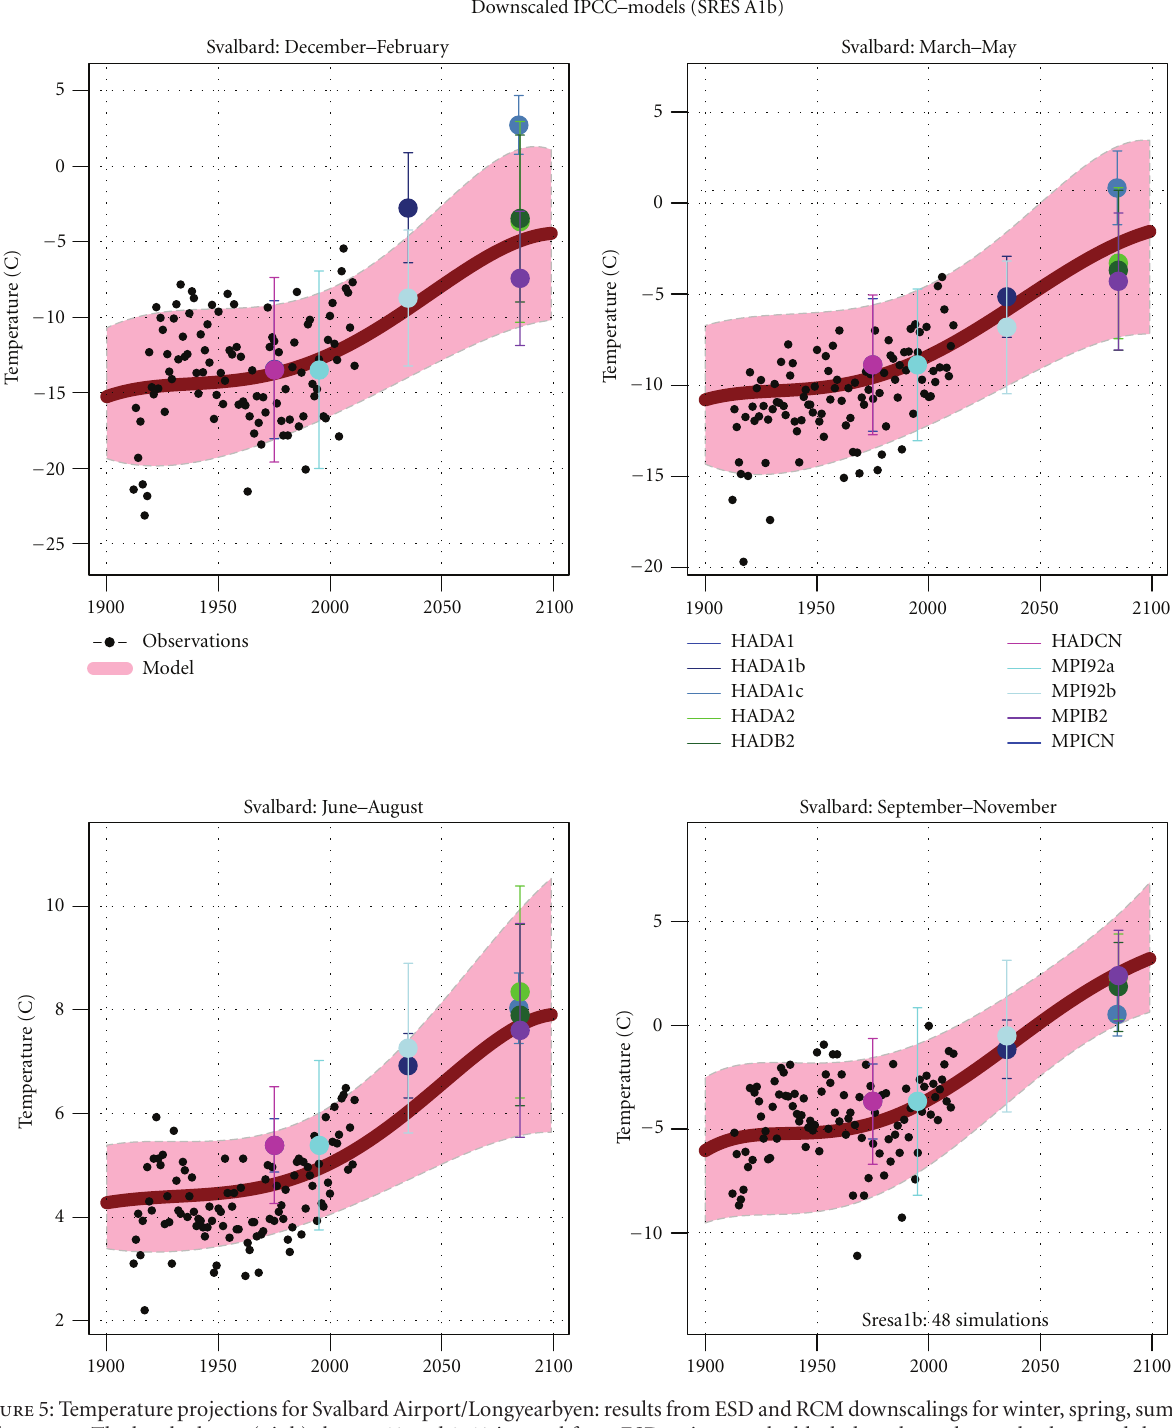
Figure 5: Temperature projections for Svalbard Airport/Longyearbyen: results from ESD and RCM downscalings for winter, spring, summer, and autumn. The hatched area (pink) shows 5% and 95% interval from ESD estimates, the black dots show observed values, and the thick line (red) show median (50%) value for the ESD ensemble. The coloured symbols indicate the median value for the di ff erent runs with NorACIA-RCM, and the vertical lines show the 5- and 95-percentiles for the RCM runs. The RCM values are plotted on the central year in the respective time slices. For acronyms, see Table